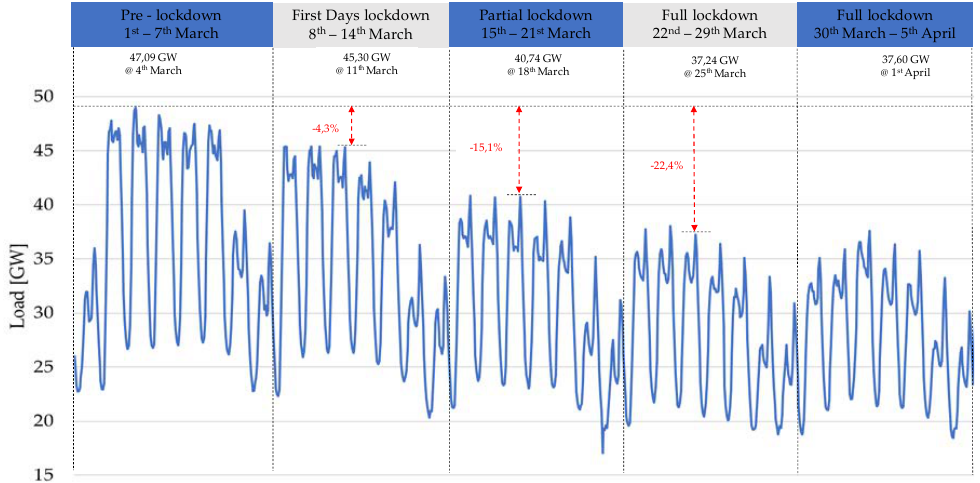
Figure 5. Five-week-load profile, 1st March–5th April 2020.